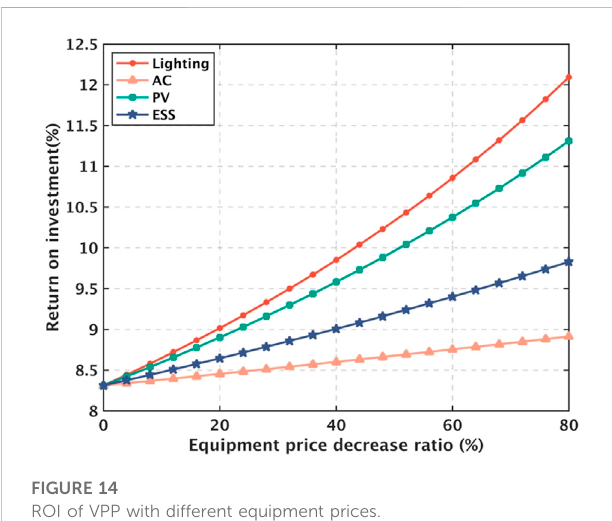
FIGURE 14 ROI of VPP with different equipment